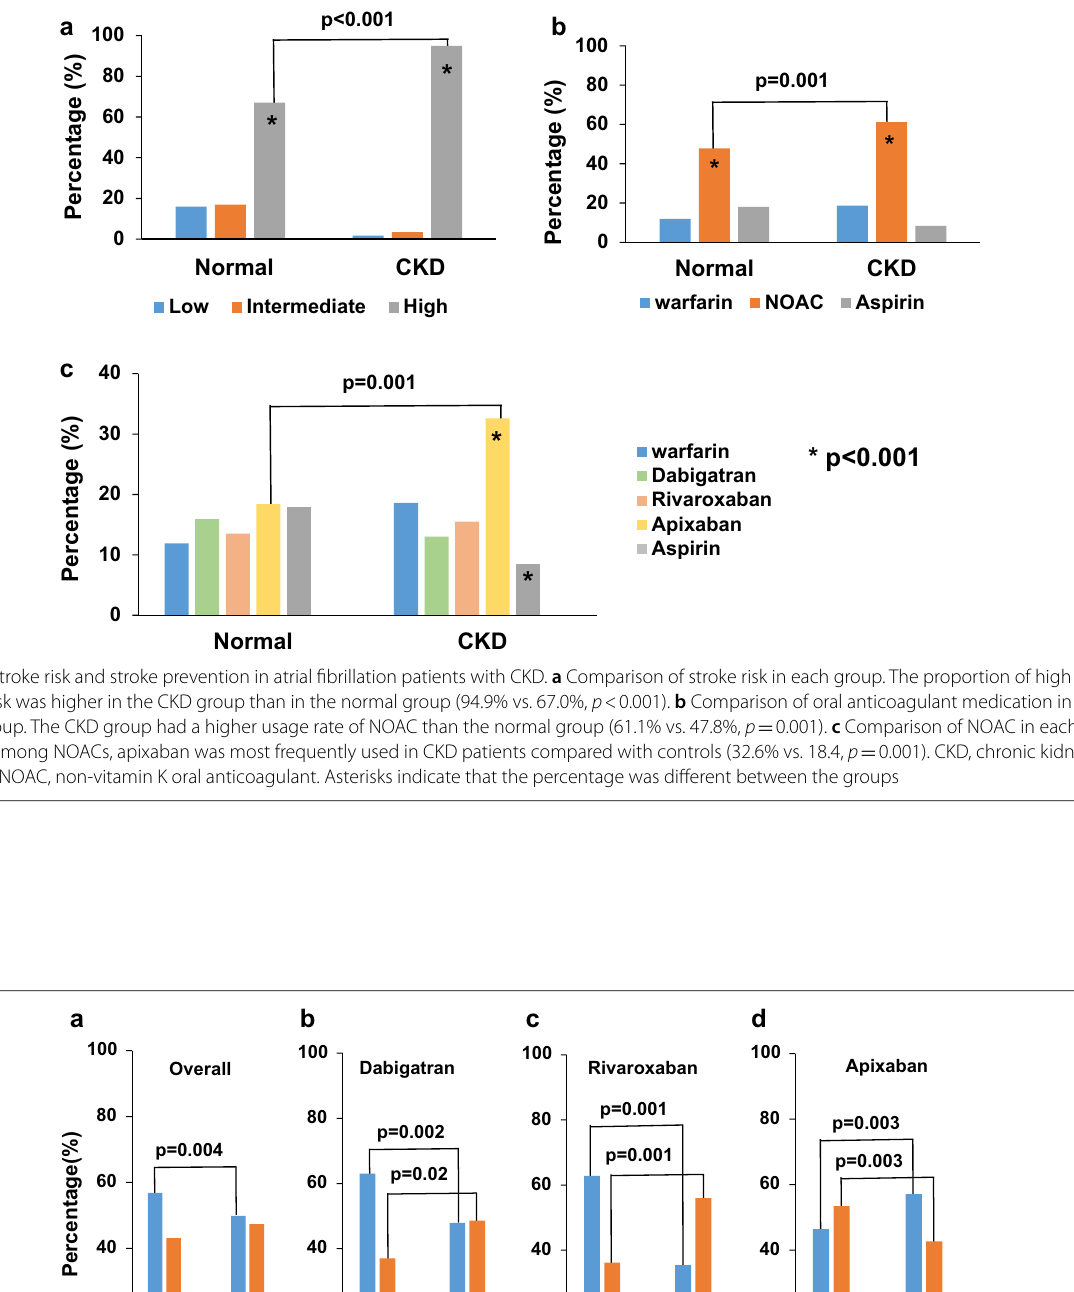
Fig. 3 Dosage of non‑vitamin K oral anticoagulants (NOACs) in CKD patients. a Overall, b dabigatran, c rivaroxaban, and d apixaban. In the overall NOACs, the underdose rate was lower in CKD patients than in normal patients. CKD patients had a lower underdose rate and a higher optimal dose rate of dabigatran and rivaroxaban. However, CKD patients had a higher underdose rate and a lower optimal dose rate of apixaban. CKD, chronic kidney